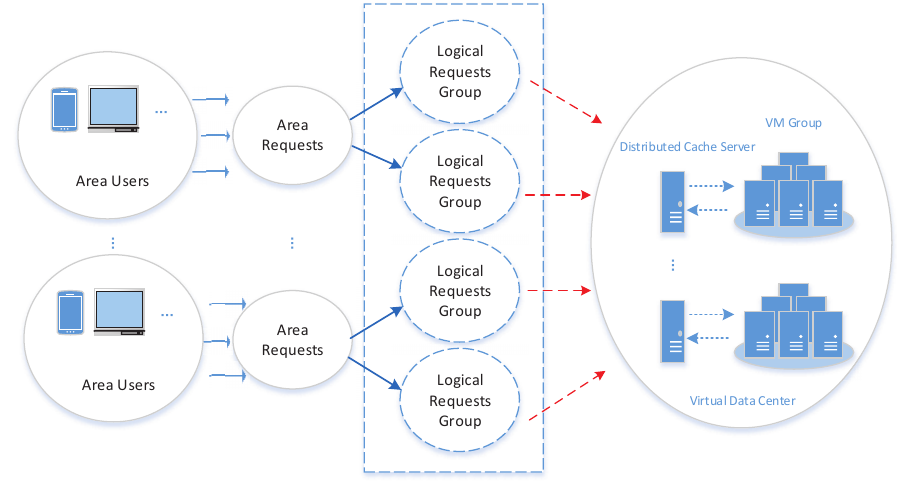
Figure 2. Synergistically distributed buffering access